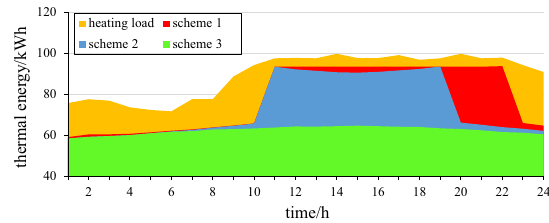
Fig. 22 Thermal energy outputs of CHP unit in summer Fig. 23 Thermal energy outputs of CHP unit in